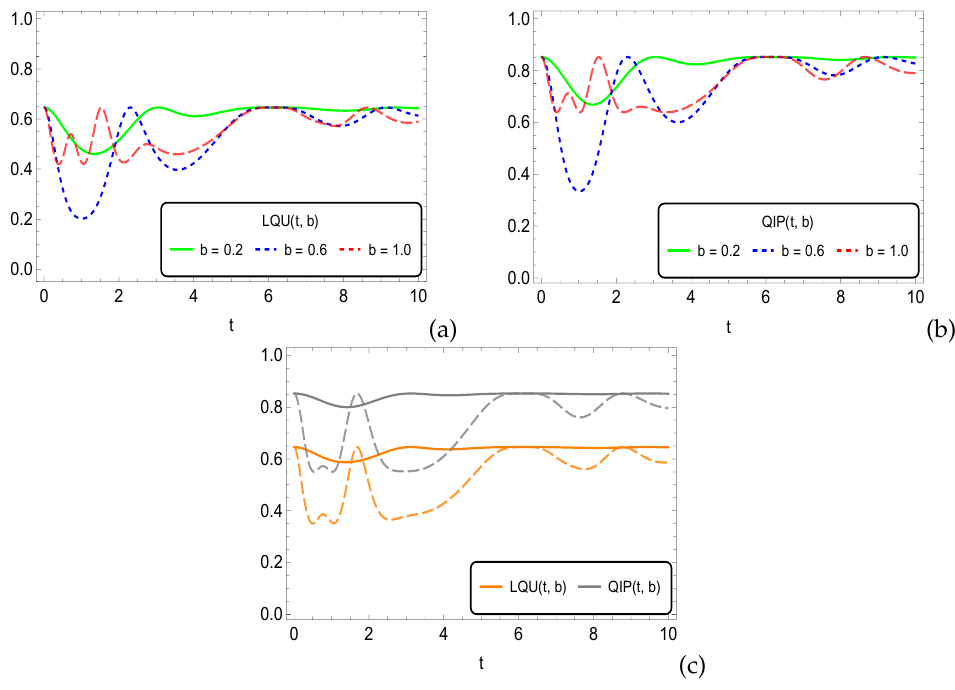
Figure 2. LQU and QIP as a function of time versus different values of b . LQU ( a ) and QIP ( b ). Graph ( c ): b = 0.1 (solid lines) and b = 0.9 (dashed lines). For all plots r = 0.9, ω = π /6, and ∆ =